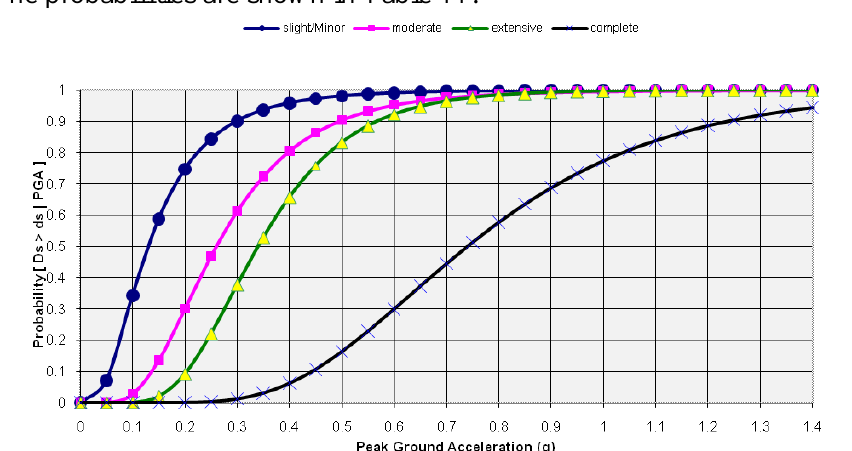
Figure 11. HAZUS fragility curves for low voltage substations with unanchored